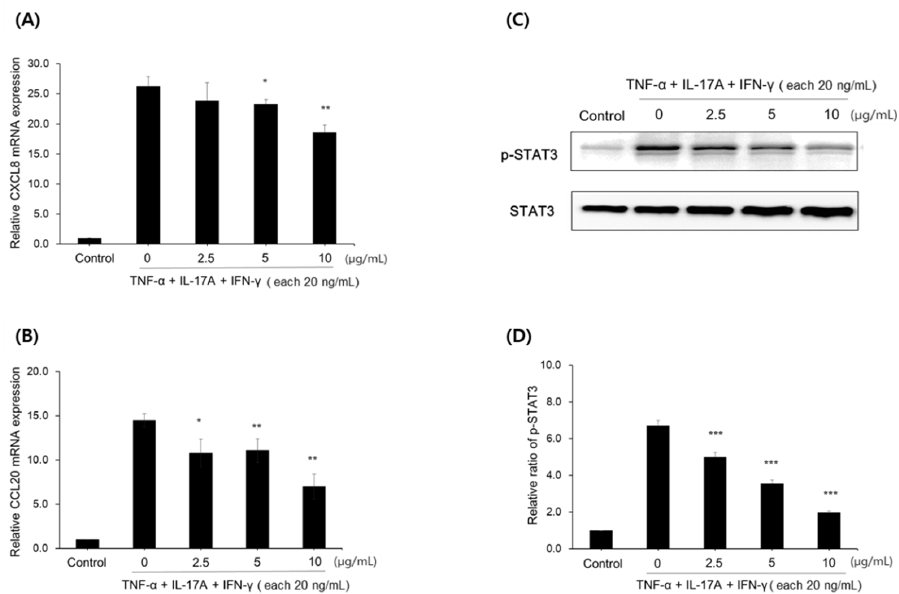
Figure 6. Effect of compound 1 on chemokines and STAT phosphorylation in TNF-α /IL-17A/ IFN- γ induced HaCaT cells. ( A ) CXCL8, ( B ) CCL20 mRNM expression and ( C ) western blots of p-STAT3 and STAT3 and ( D ) quantitative expression of p-STAT3/STAT3. All data are presented as the mean± SEM ( n = 3). * p < 0.05 and ** p < 0.01, *** p < 0.001 indicate significant differences compared to the TNF-α /IL-17A/ IFN-γ control group.